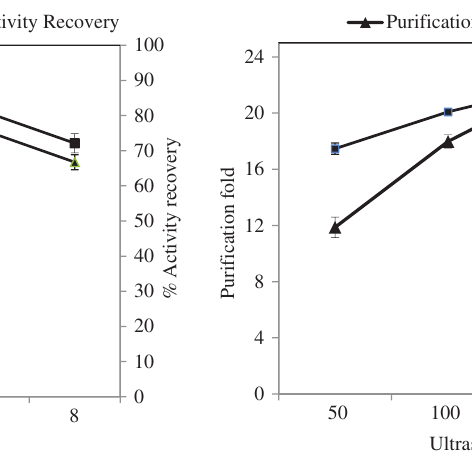
Figure 6: Effect of ultrasound power on ultrasound assisted three phase partitioning (UATPP) of peroxidase.